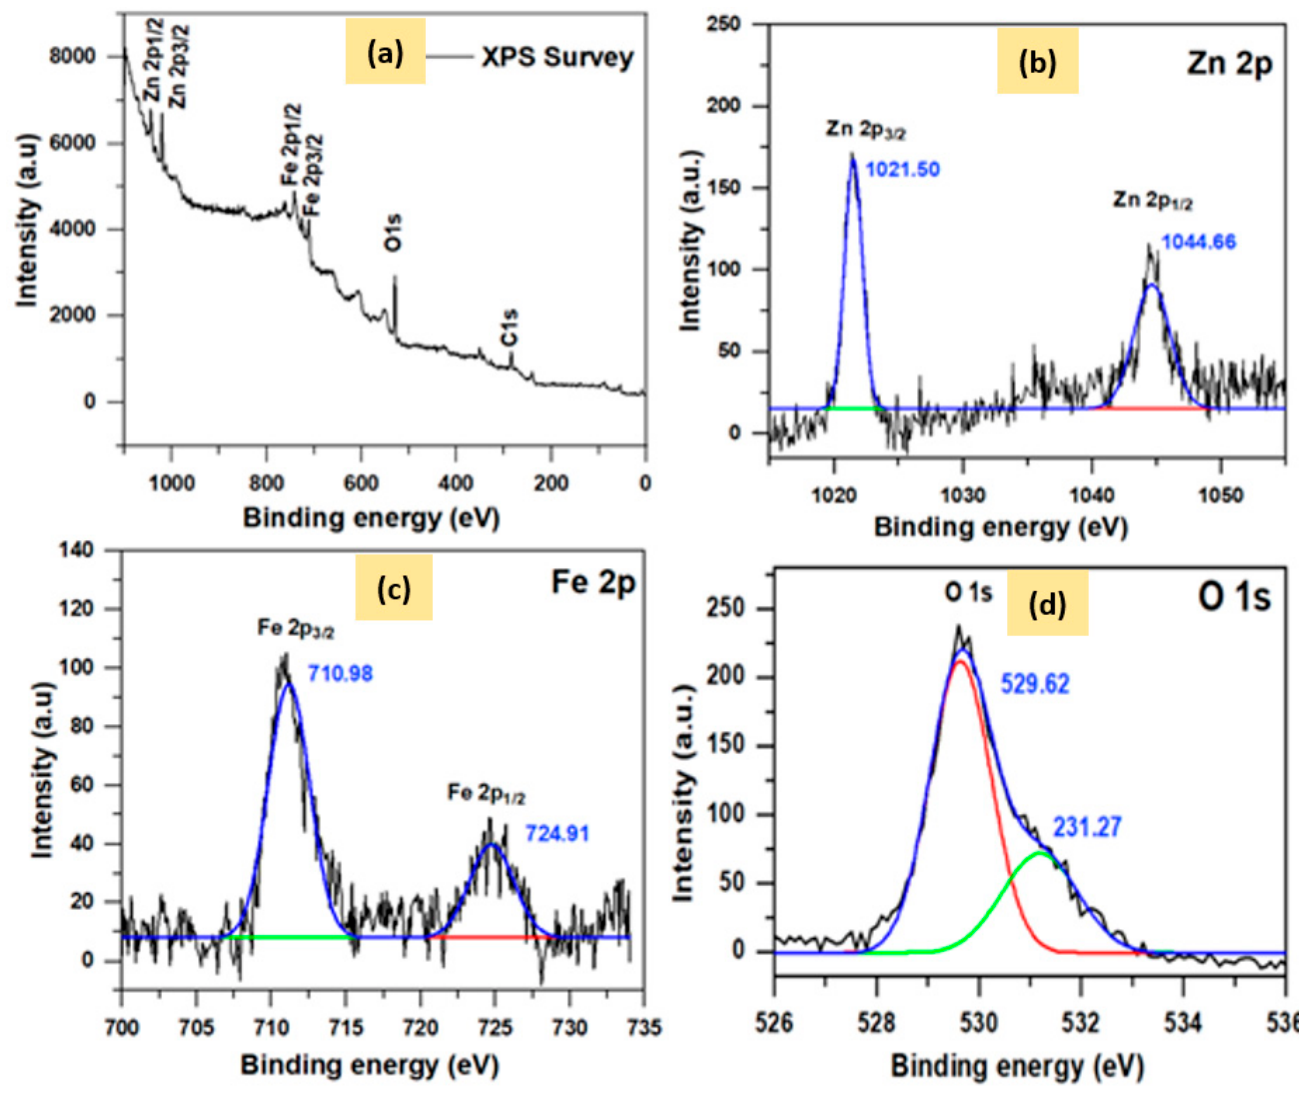
Figure 7. XPS spectra of ZFNPs. ( a ) wide XPS spectra, ( b ) narrow Zn 2p, ( c ) narrow Fe 2p, and ( d ) narrow O 1s.